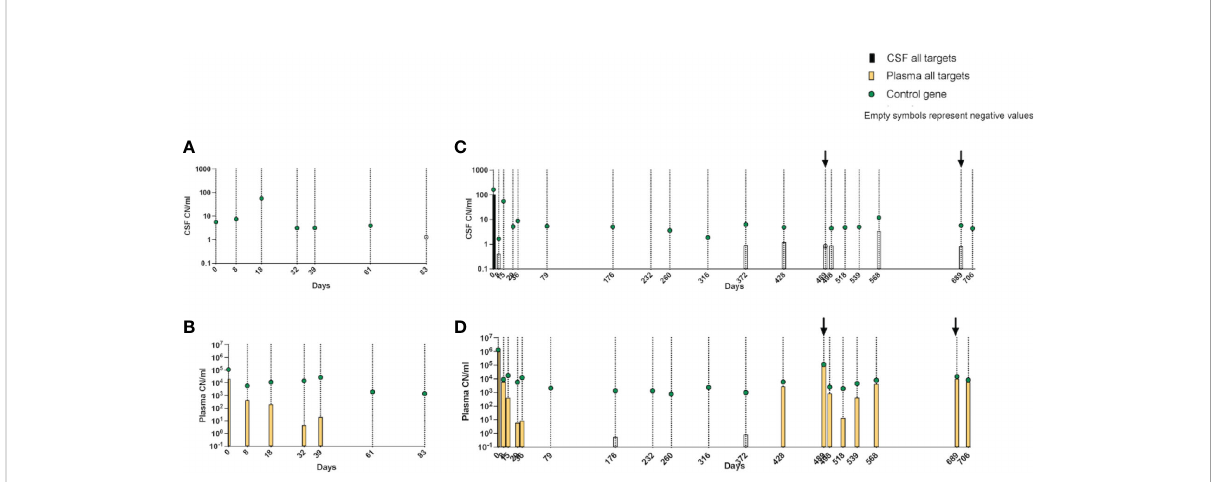
FIGURE 6 (A – D) Kinetics of leukemic targets in CSF and plasma by ddPCR during treatment. (A) CSF and (B) plasma results in patient 3. (C) CSF and (D) plasma results in patient 4. Empty symbols denote trace values (1 – 2 positive droplets). CSF, cerebrospinal fl uid; ddPCR, droplet digital